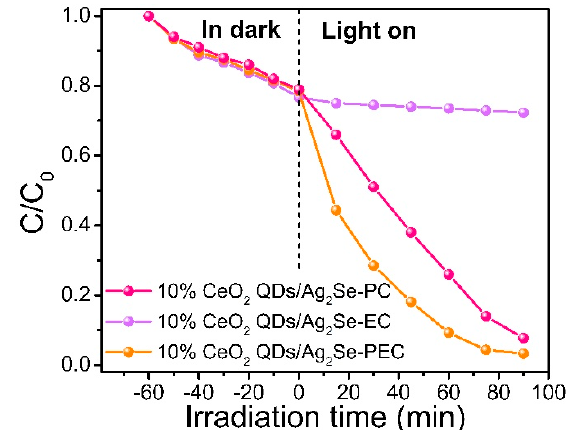
Figure 11. Adsorption and photocatalytic (PC), electrocatalytic (EC), and photo-electrocatalytic (PEC) degradation effects of TC (0.02 g/L, 50 mL) by 10% CeO 2 QDs/Ag 2 Se Z-scheme nano-heterojunction.